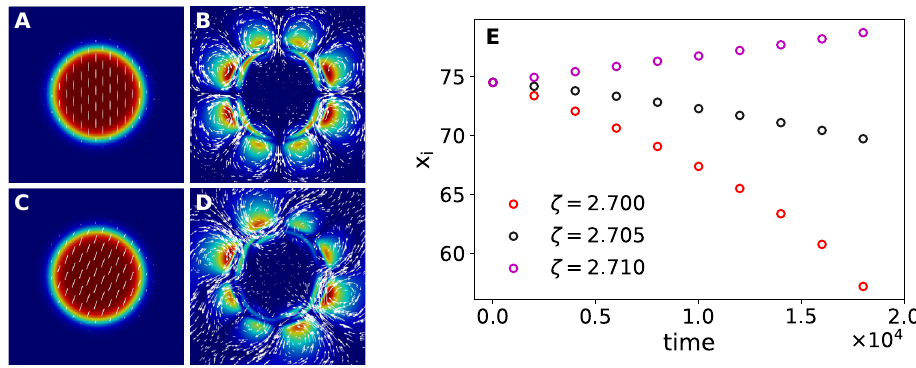
Figure 1. Order parameter for flat interfaces at di ff erent temperatures and at time t = 350000: A) γ = 2 . 699, B) γ = 2 . 7, C) γ = 2 . 701. The velocity field is below the machine precision everywhere for Figure 2. Order and velocity fields of an almost static circular interface at two di ff erent director ori- γ = 2 . 7. D) Scalar order parameter at y = L / 2. The solid line is the analytical expression given by Y entations. The temperature, γ = 2 . 707681 was chosen to minimize the interfacial velocity and the Eq. (10) for S n = 1 / 3 and λ = 2 and the circles are the simulated results. The inset shows the interface screenshots were taken at t = 35000. The system size is 100 velocity at di ff erent temperatures. At coexistence γ = 2 . 7, the interface velocity is below the machine A) Order parameter (colors) and directors (lines) for n y = 1 and n x = 0. B) Vorticity field (colors) and precision. direction of the velocity field (arrows). C and D depict the same fields as A and B, but for n y = cos(20 ◦ ) and n x = sin(20 ◦ ). In this color map, the red and blue represent the maximum and minimum values of the field. The maximum velocity (norm) in B is u max = 8 . 97 Interface velocity at three di ff erent